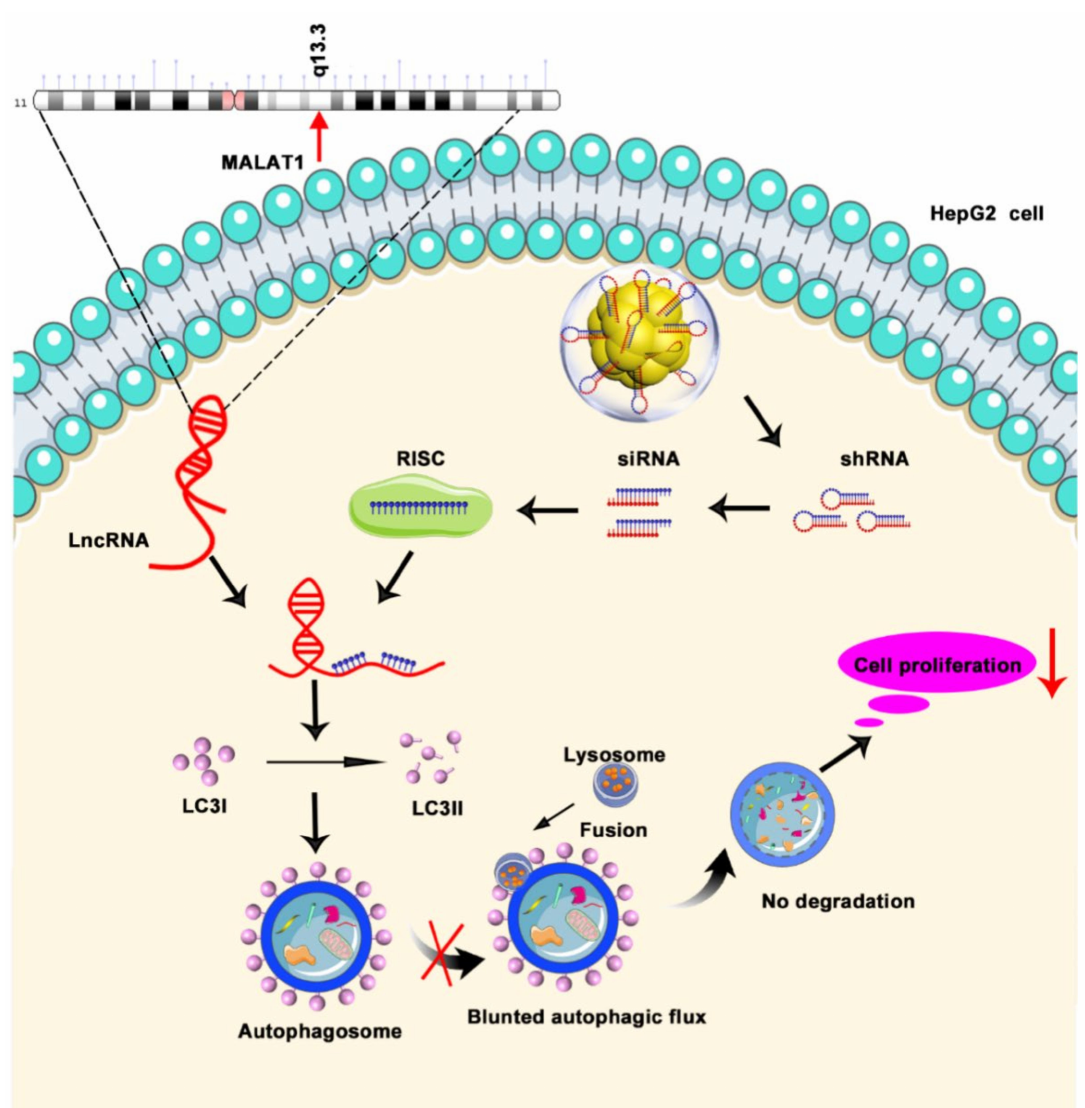
Figure 7. Schematic diagram of the potential mechanism by which Au–shRNA1 NCs effectively silence MALAT1 to inhibit the proliferation of HepG2 cells via the suppression of